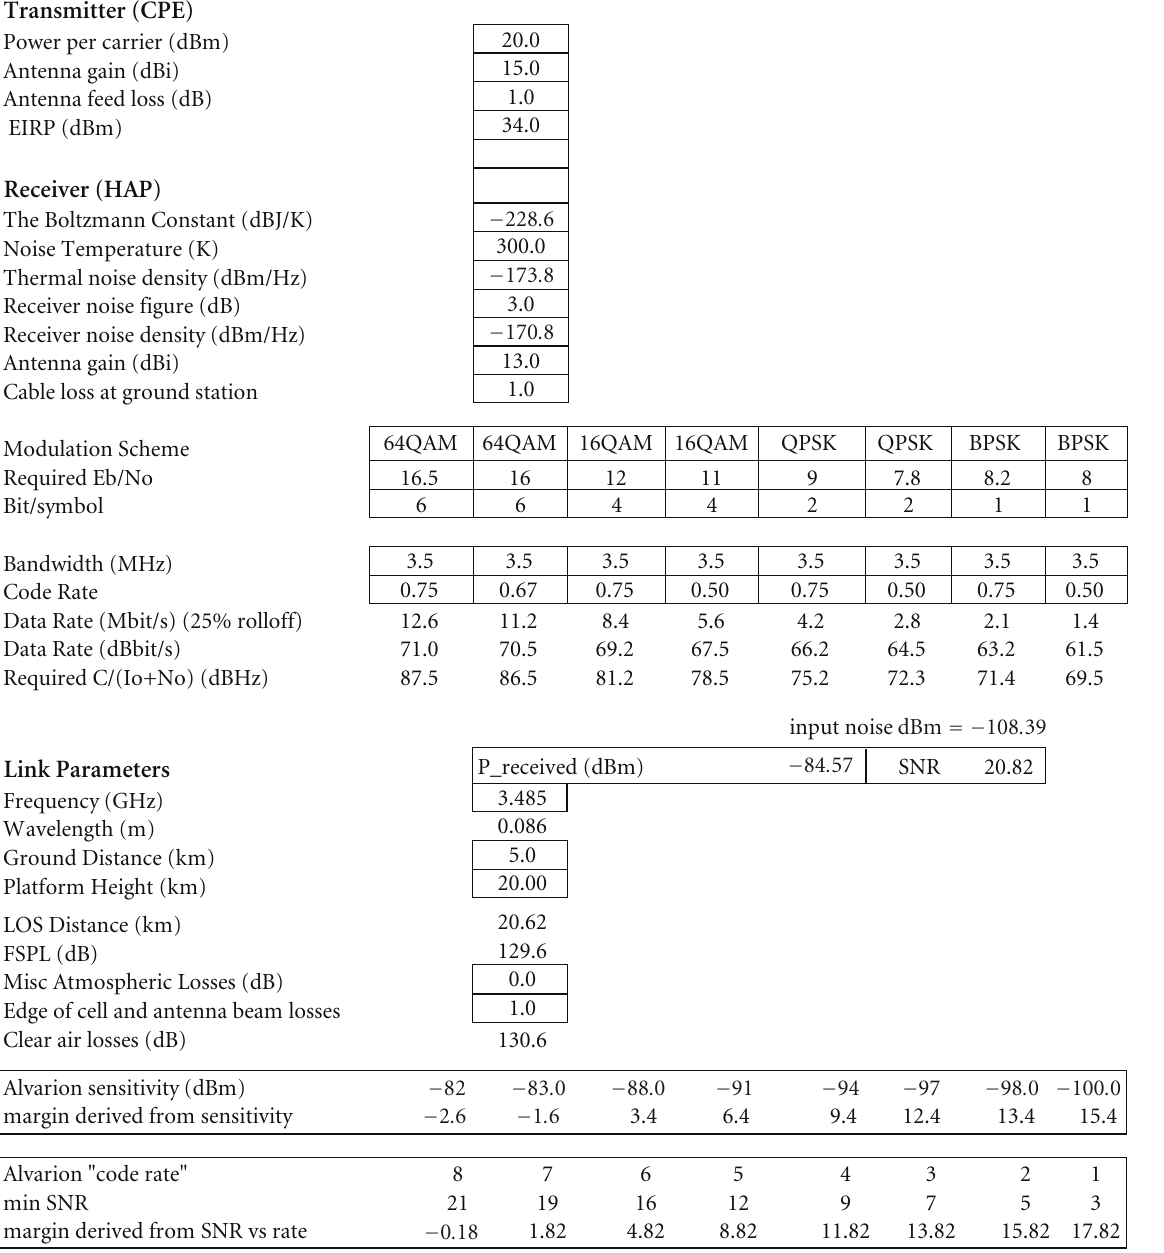
Table 4: Form of typical link budget